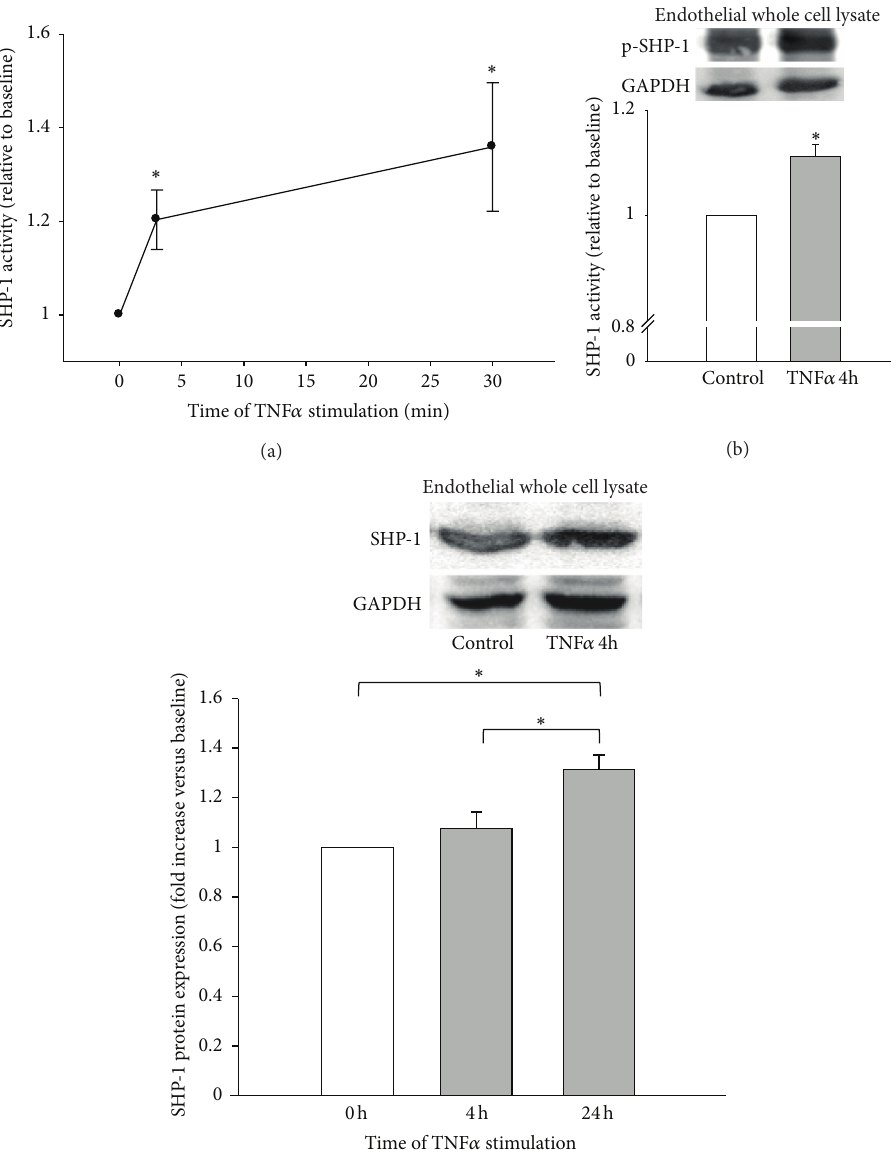
Figure 5: TNF 𝛼 increases SHP-1 activity and protein expression. (a) TNF 𝛼 (5ng/mL) treatment of endothelial cells increased SHP-1 activity already within minutes of stimulation as assessed by pNPP-dephosphorylation assay in PAEC ( 𝑛 = 6 – 8 ). (b) This could also be observed in HUVEC after TNF 𝛼 stimulation (5ng/mL, 4 h) as detected by phosphorylation of SHP-1 at Y564. (c) SHP-1 protein expression was not changed within the first hours of stimulation but significantly increased after 24 hours of stimulation. ∗ Significantly different versus baseline or as indicated at 𝑃 < 0.05 ( 𝑛 = 6 – 8